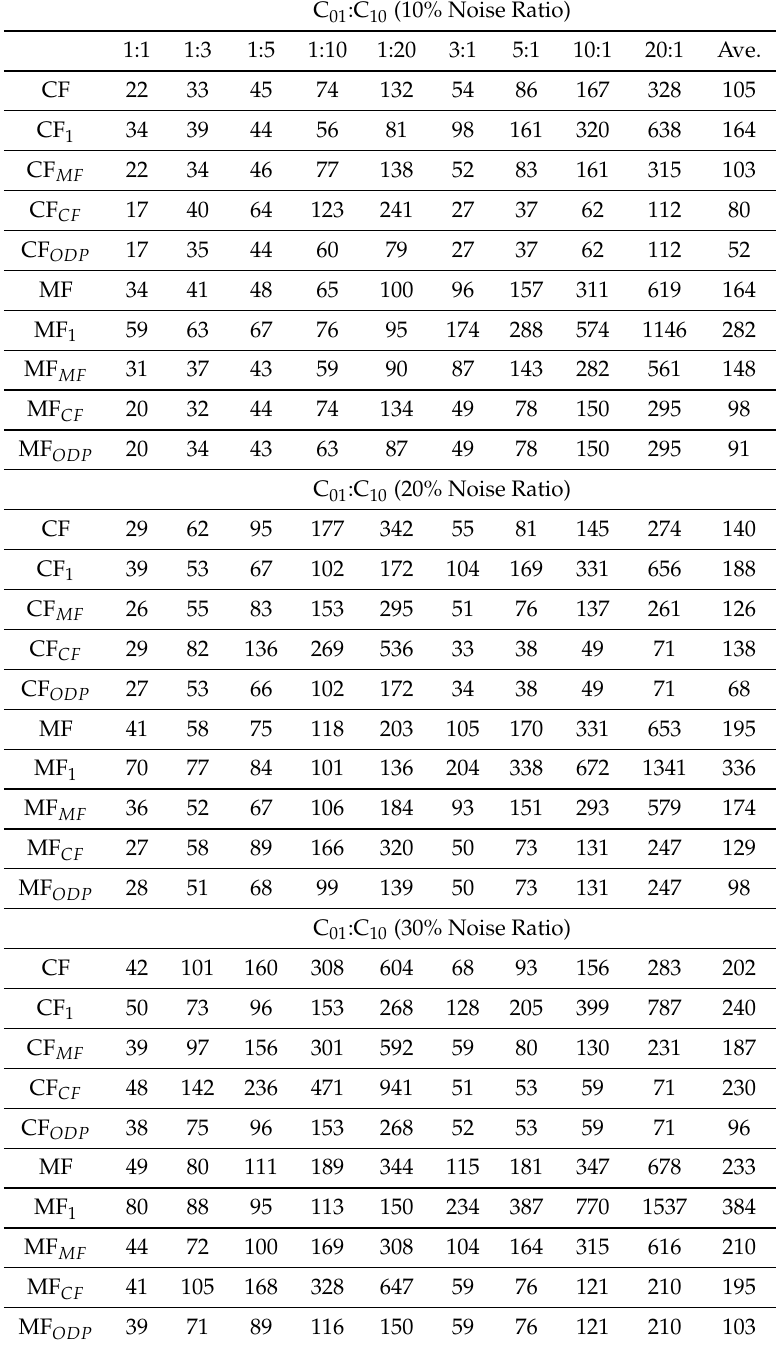
Table 3. Cost comparisons on Heart. Ave., average; CF, consensus filter; MF, majority